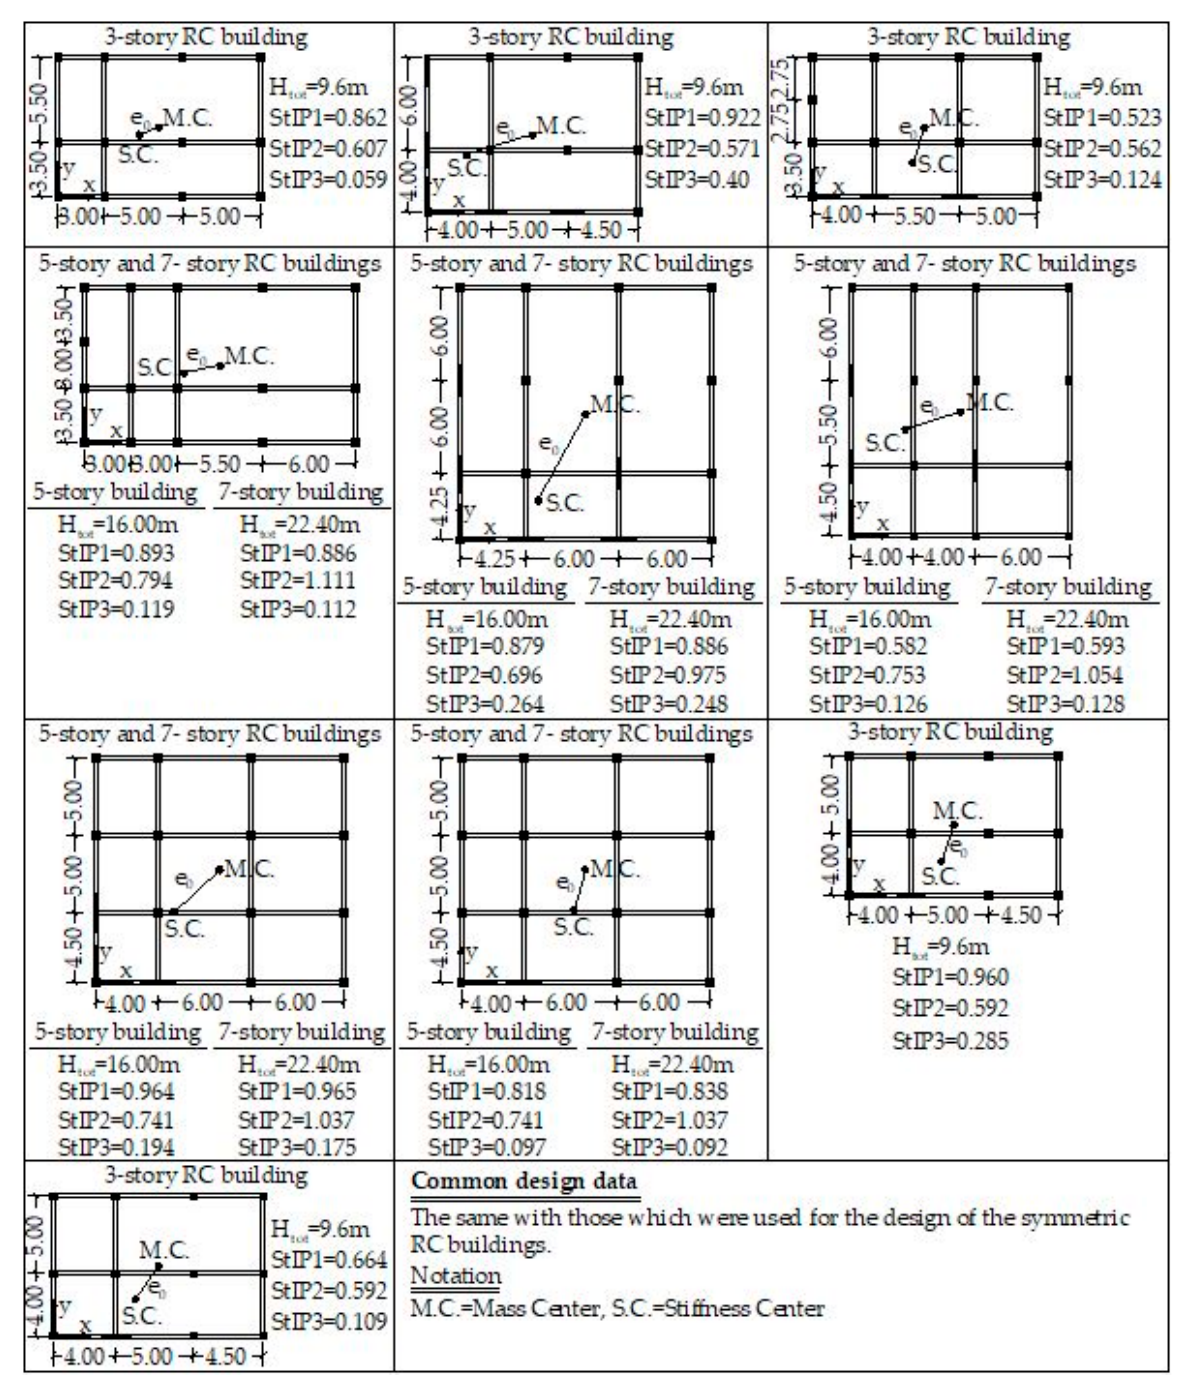
Figure A2. Design data of the 15 selected asymmetric RC buildings.